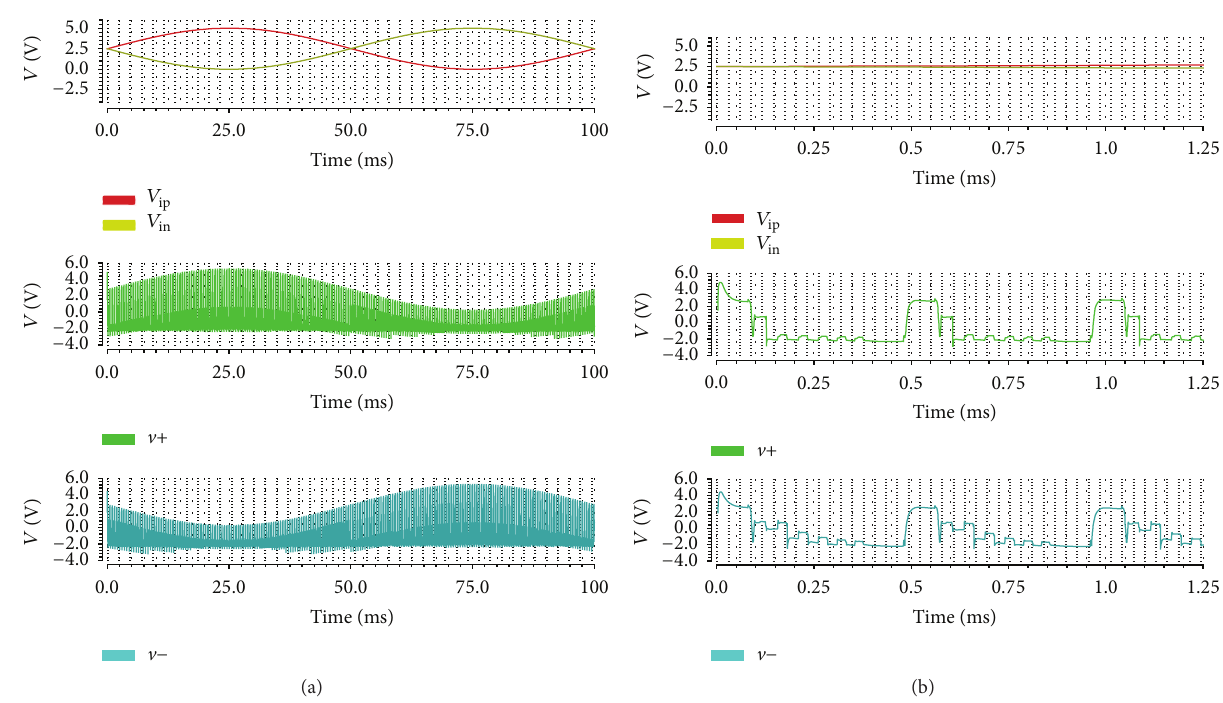
Figure 12: Cycle of T/H block outputs: (a) full and (b) partly magnified in time.